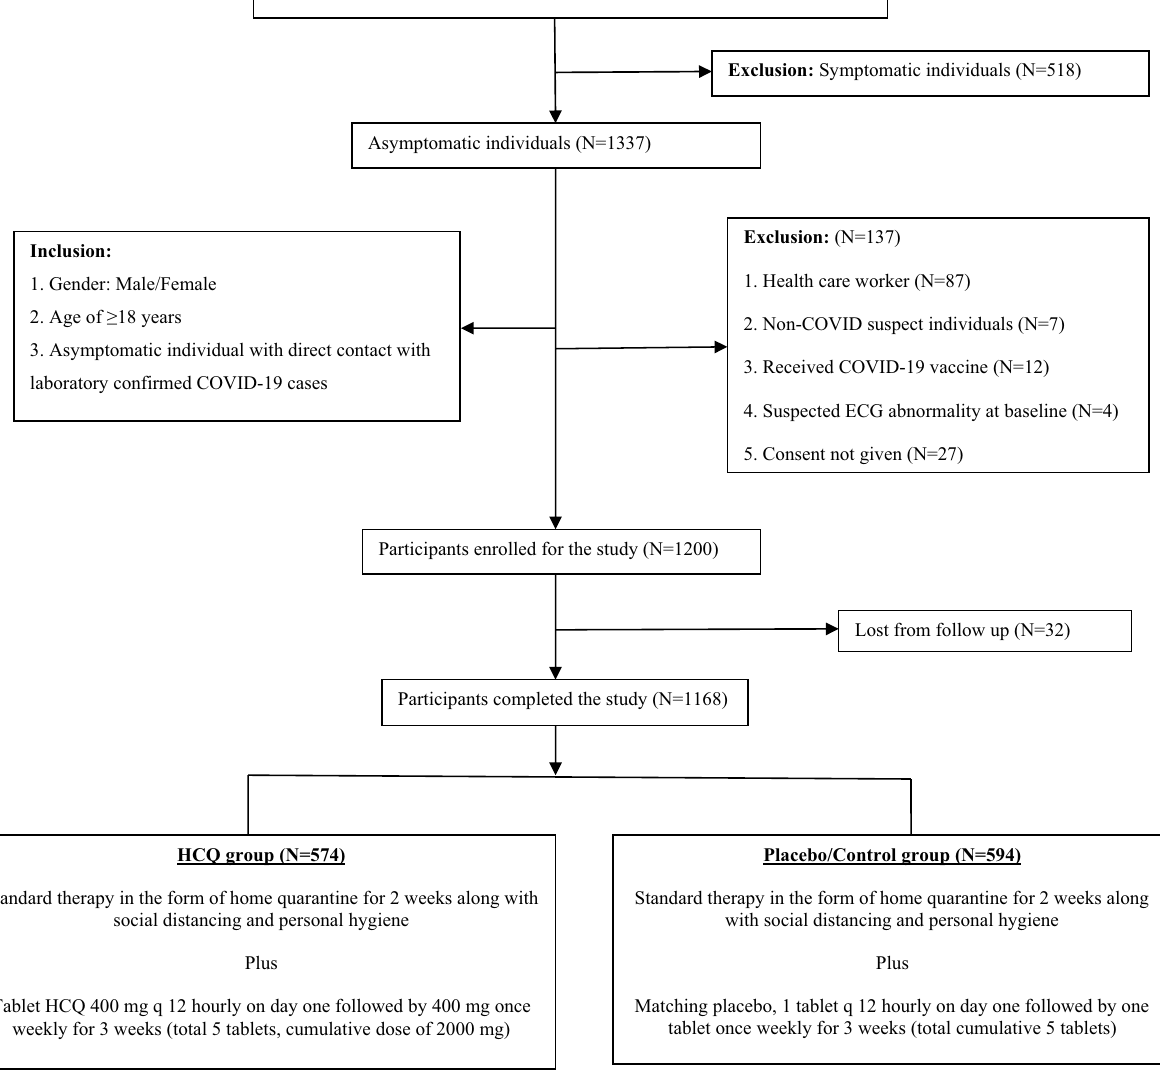
Figure 1. Study design, screening and